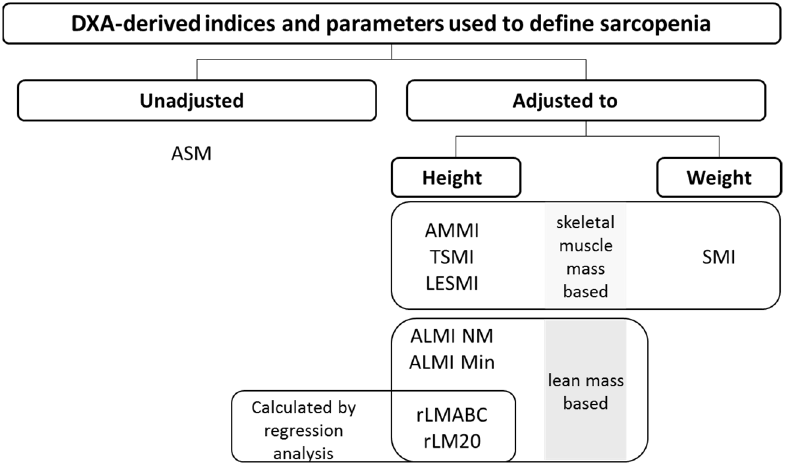
Figure 1. Allocations of indices to adjustment or baseline parameter for calculation. DXA: dual-energy X-ray absorptiometry; ASM: appendicular skeletal muscle mass; AMMI: appendicular skeletal muscle mass index; TSMI: total skeletal mass index; LESMI: lower extremity skeletal muscle mass index; SMI: skeletal muscle mass index; ALMI: appendicular lean mass index; Min: reference values Minnesota; NM: reference values New Mexico; rLMABC: relative lean mass (20th percentile ABC Health study); rLM20: relative lean mass (20th percentile).